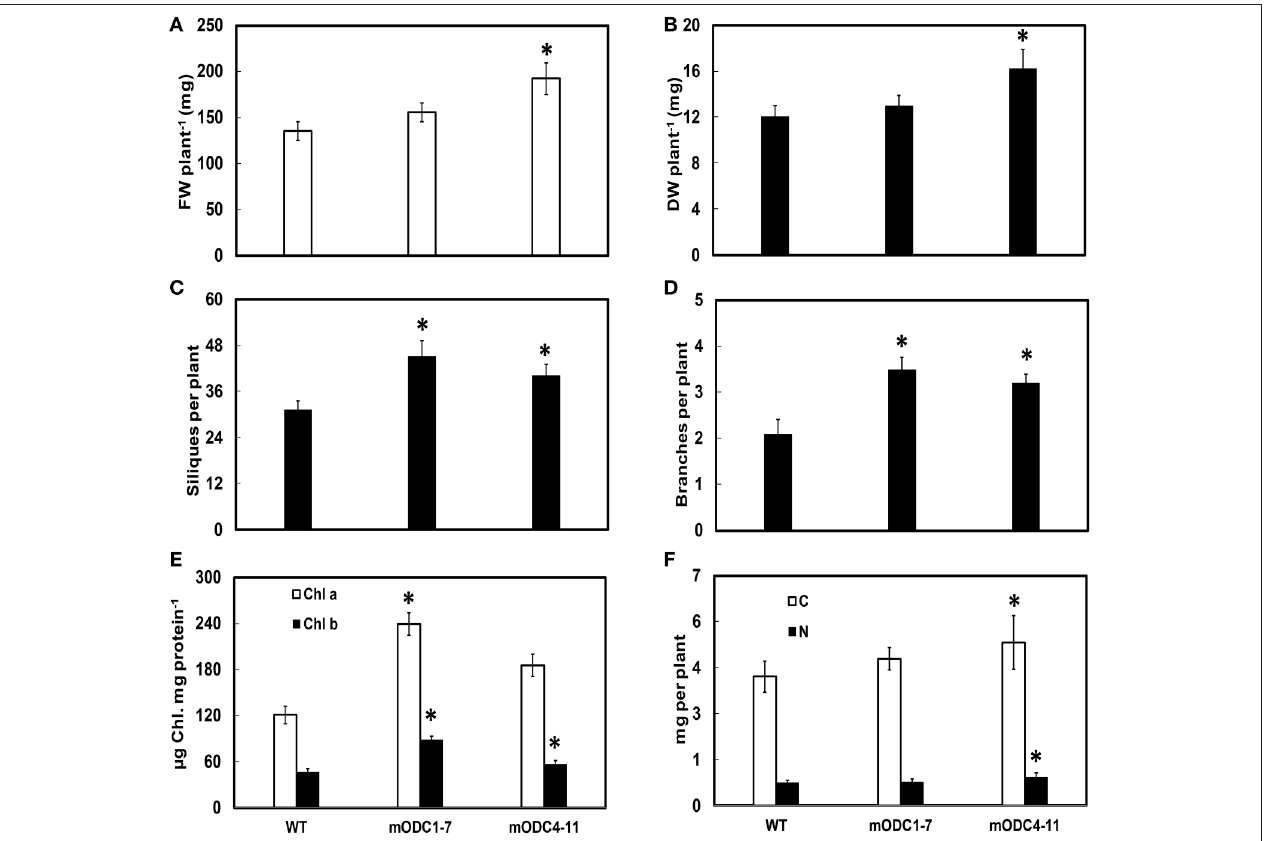
FIGURE 5 | Comparison of different phenotypic and related biochemical parameters between WT and m ODC transgenic Arabidopsis thaliana plants for (A) fresh weight ( n = 9 ), (B) dry weight ( n = 9 ), (C) silique number ( n = 7 ), (D) number of branches ( n = 10 ), (E) leaf chlorophyll concentration ( n = 4 ), and (F) total carbon and nitrogen concentrations ( n = 10 ). Data are mean ± SE. Plants for (A–E) were 6 week-old and near full maturity. * Denotes significant difference between WT and m ODC transgenic plants ( P ≤ 0.05